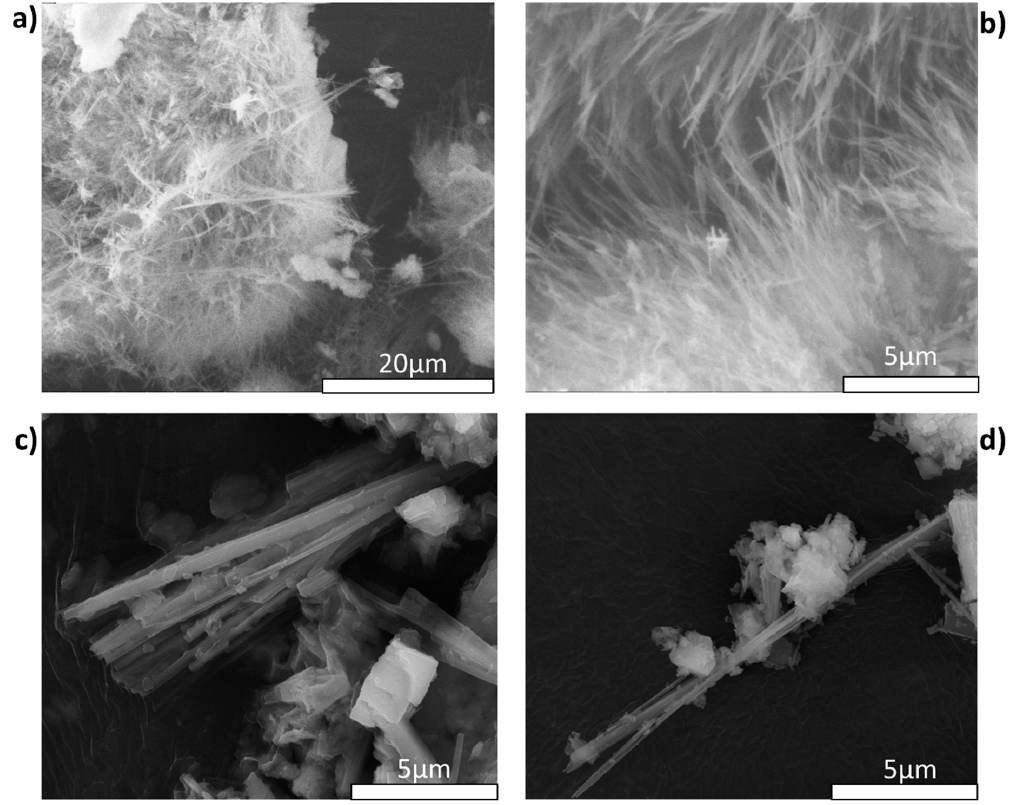
Figure 6. Gallery of SEM image of diagenetic mordenite. ( a , b ) Mordenite from Ponza Island (Italy). Fibers show a typical asbestiform habit. ( c , d ) Mordenite from Lovelock (Nevada, USA). The fibers bundles tend to separate into thin and quite rigid fibrils.